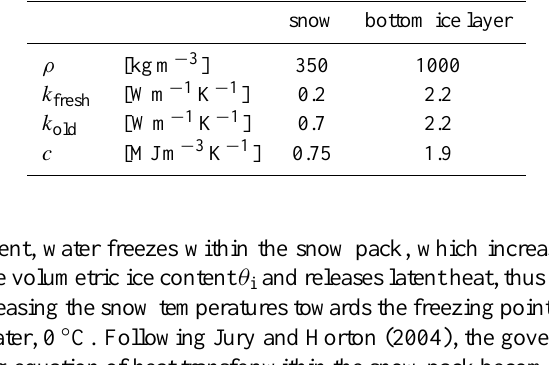
Table 3. Snow and ice properties employed in the model. snow bottom ice layer